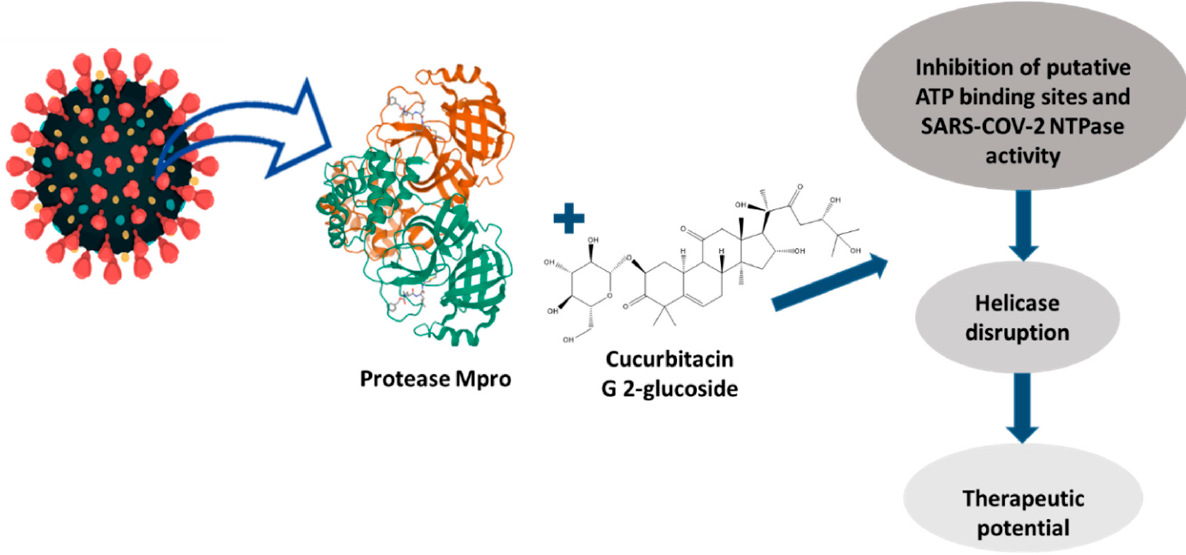
Figure 4. Possible mechanism of action of cucurbitacin G2-glucoside against protease Mpro SARS-CoV-2.